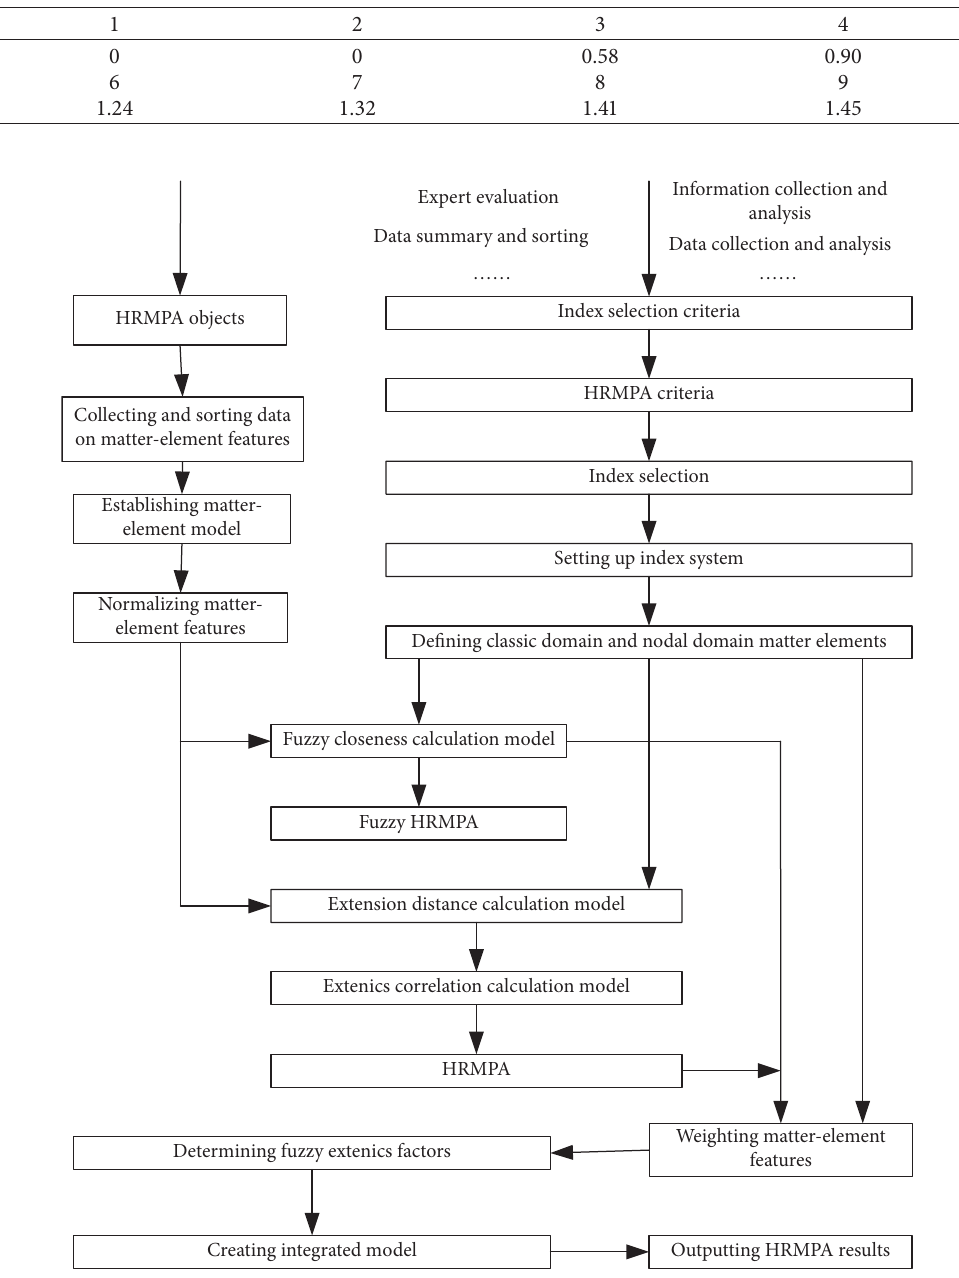
Figure 3: Framework of corporate HRMPA based on extenics